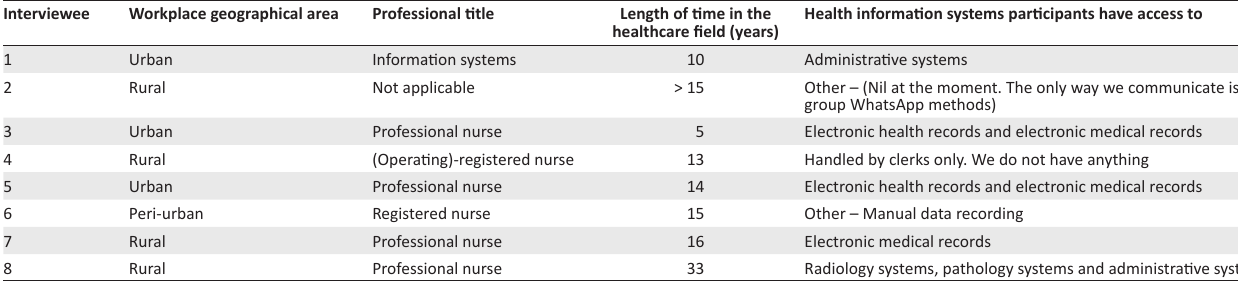
TABLE 2: Demographic information of the